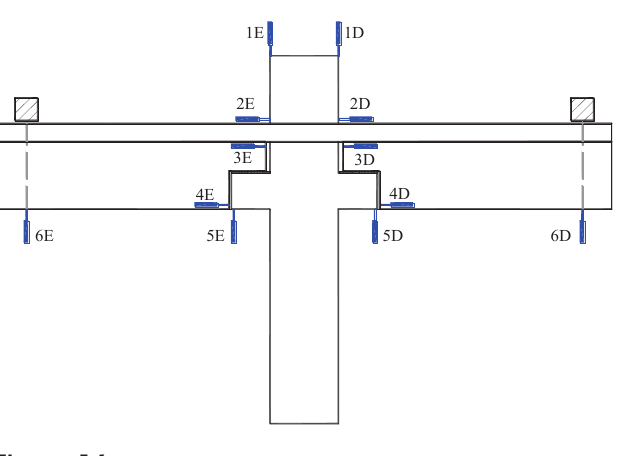
Figure 17 General view of the equipment used in the tests for measuring strains, displacements and loads